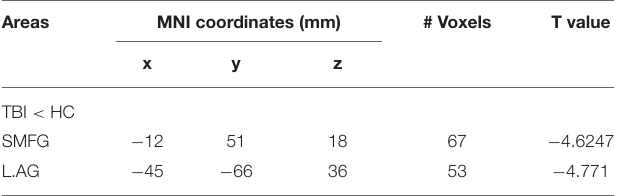
TABLE 2 | Statistical values of rest-state functional connectivity comparison in the left substantia nigra (SN).